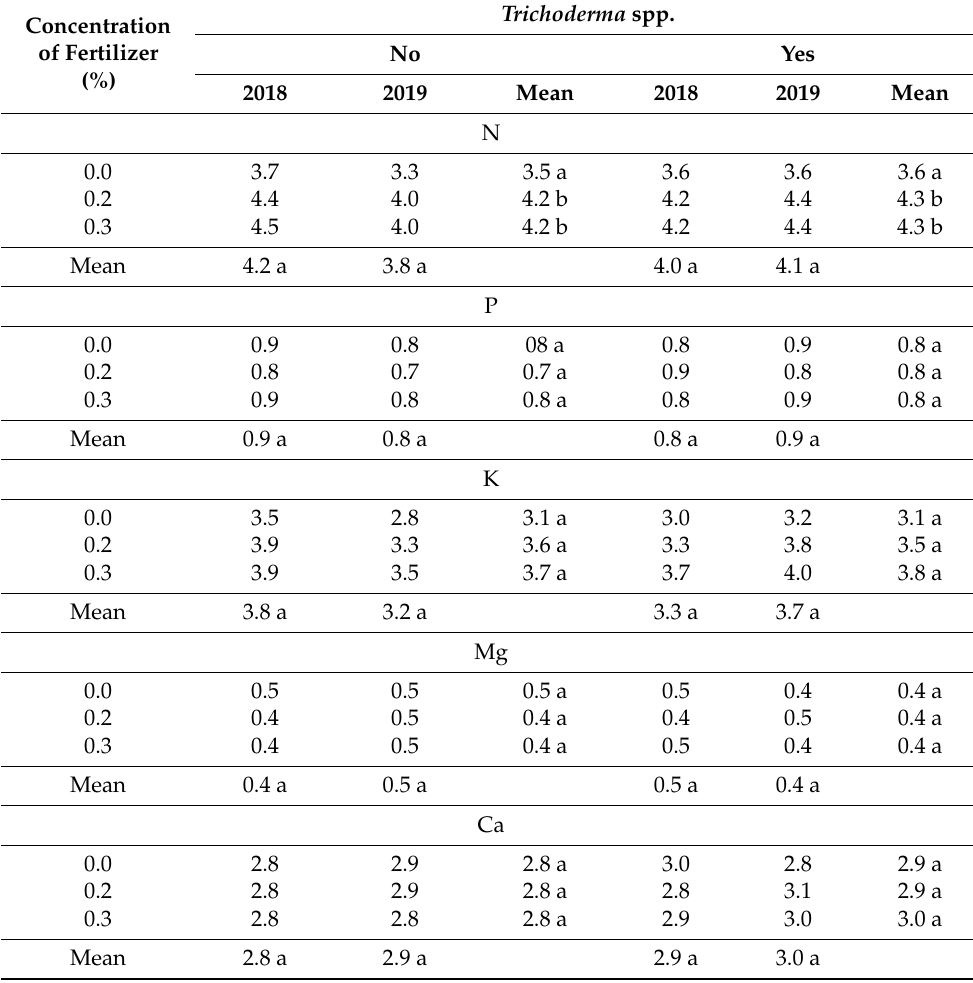
Table 3. Content of macroelements (% DW) in leaves of Begonia × tuberhybrida ‘Picotee Sunburst’ after application of Trichoderma spp. and different fertilization level. Means followed by the same letter for column-wise and row-wise do not differ significantly at α =